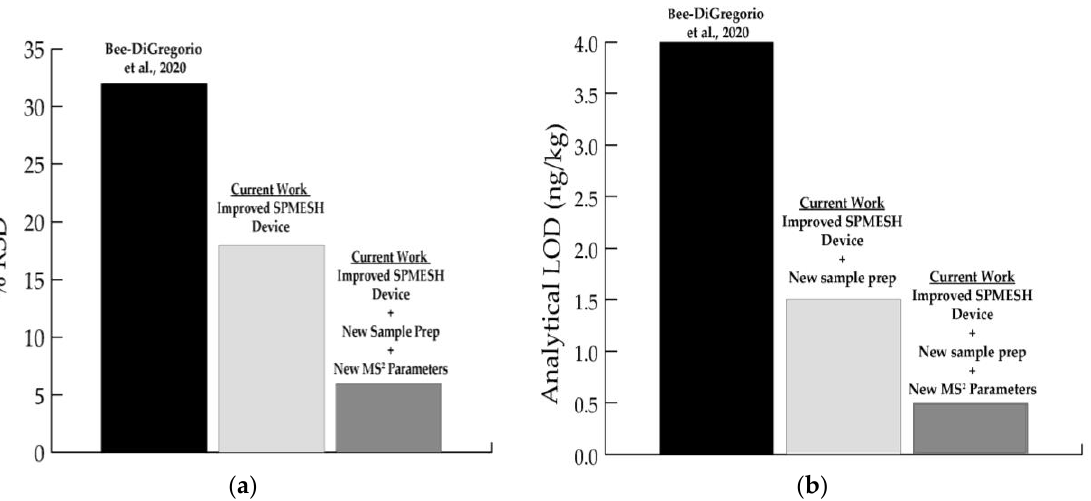
Figure 2. Comparison of reported relative standard deviation values from previous work (Bee et al., 2020) [13], samples analyzed with improved SPMESH extraction device, and samples analyzed using improved SPMESH extraction device and optimized conditions ( A ). Comparison of analytical limits of detection from (i) Bee-DiGregorio et al., 2020 [13],(ii) current work with optimized sample prep and new device, and (iii) improved device, optimized sample prep, and optimized MS/MS parameters ( B ).